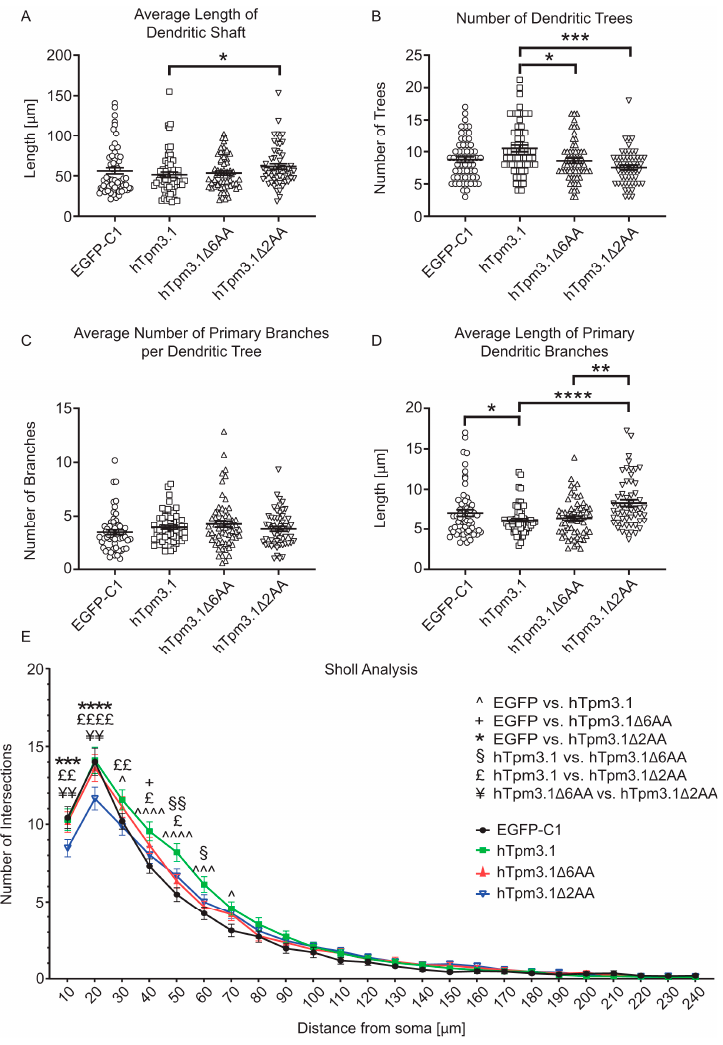
Figure 6. Quantitative analysis of dendritic morphology of C57/Bl6 hippocampal neurons. Mouse primary hippocampal neurons expressed EGFP-C1, hTpm3.1, hTpm3.1 ∆ 6AA and hTpm3.1 ∆ 2AA for 48 h and were fixed at 4DIV. The analysed dendritic morphological parameters are: ( A ) average length of dendritic shaft, ( B ) number of dendritic trees, ( C ) average number of primary branches per dendritic trees, ( D ) average length of primary dendritic branches, and ( E ) Sholl analysis. In total, 55–60 neurons from three biological replicates (with at least 15 neurons per replicate) were analysed for each construct. Error bars represent standard error of the mean. Significance was determined by Kruskal–Wallis test with Dunn’s correction for multiple comparisons: * p < 0.05, ** p <